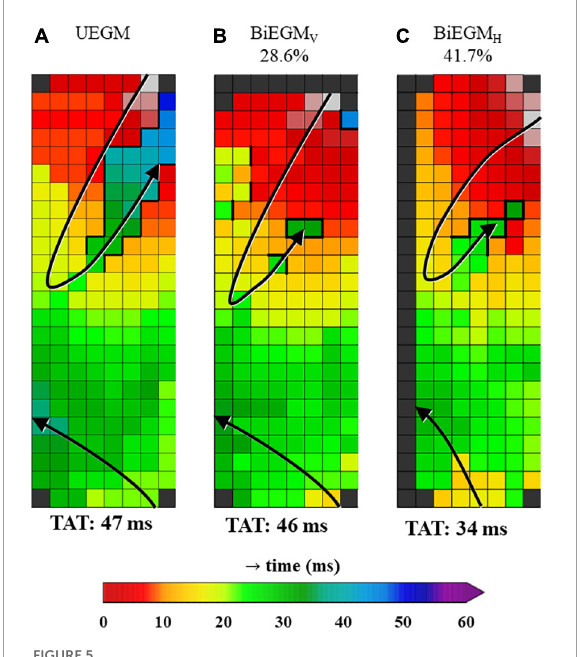
FIGURE5 Unipolar and corresponding bipolar vertical and bipolar horizontal activation map obtained from one patient. The percentages on top of the activation maps show how often the amplitude of the LOM was larger than the amplitude of LA tissue for bipolar activation maps. (A) Map was constructed using unipolar EGMs in which all negative deflections were annotated (UEGM). (B) Map was constructed using bipolar EGMs, created by subtracting EGMs in vertical direction (BiEGM V ). (C) Map was constructed using bipolar EGMs, created by subtracting EGMs in horizontal direction (BiEGM H ). EGM, electrogram; LA, left atrium; LOM, ligament of Marshall; TAT, total activation time. The bold black lines represent lines of conduction